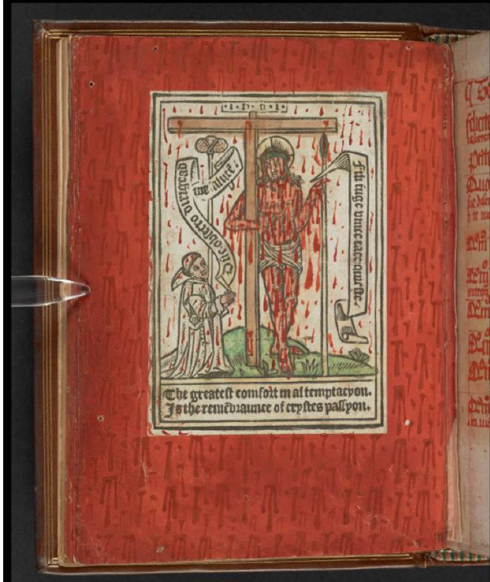
Figure 5. The last of the woodcuts depicts Christ holding the lance or scribal pen that has pained the side wound on his skin. His entire body is covered in blood and so is the head and habit of the kneeling Carthusian Monk by his side. A world covered in blood. MS Egerton 1821, fol. 9v. British Library, London.